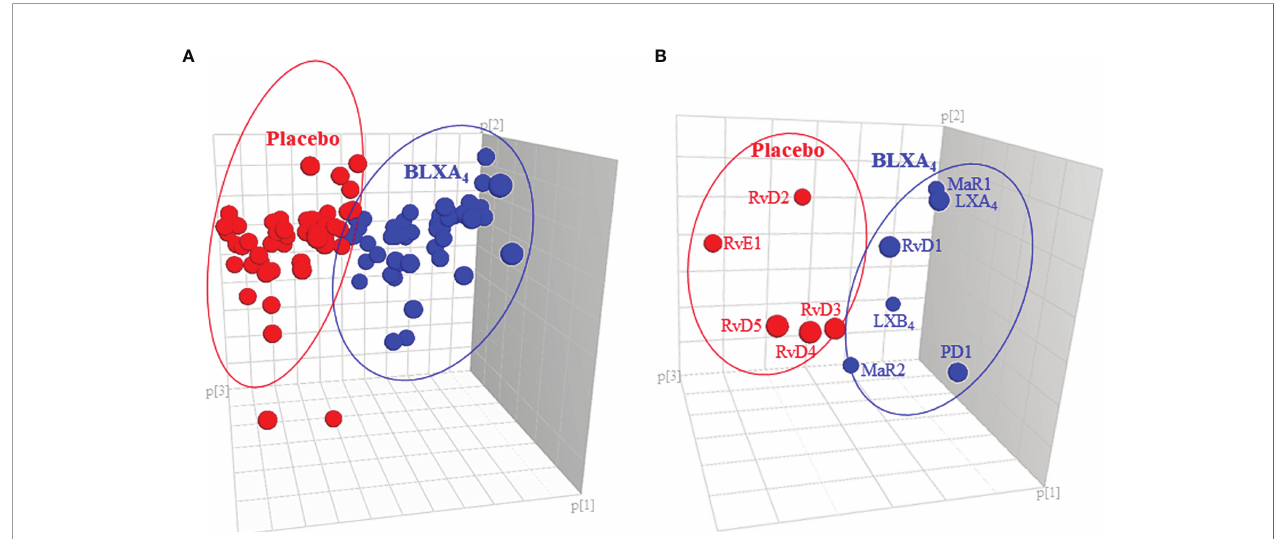
FIGURE 6 | Impact of local BLXA 4 treatment on the systemic in fl ammatory response. Quantitation and recovery of LMs in serum at baseline and at the end of the treatment on Day 28 were determined using the deuterium labeled internal standards (d8-5-HETE, d5-RvD2, d5-LXA4, d4-LTB4, d4-PGE2; d5-MaR2; 500 pg/ m L), and a LM-SPM pro fi le was constructed for each sample. Principal component analysis (PCA) was carried out to classify the observations (change in the BLXA 4 and placebo groups) on the basis of lipid mediator levels. (A) 3D score plot of SPMs in serum at Day 28. Lipidomics pro fi les clearly separated the subjects treated with BLXA 4 from placebo. (B) 3D loading plot of SPMs in serum at Day 28. Local treatment with BLXA 4 signi fi cantly increased the abundance of SPMs in serum and distinctly separated the BLXA4-treated group from placebo group in the composition of lipid mediators indicating a shift in systemic in fl ammatory response toward resolution correlating with clinical fi